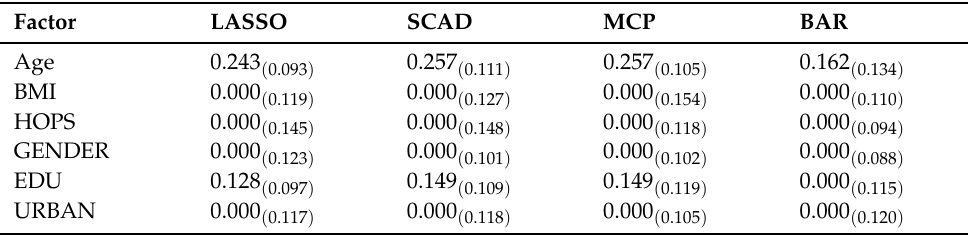
Table 9. Analysis results of children’s mortality data based on choice